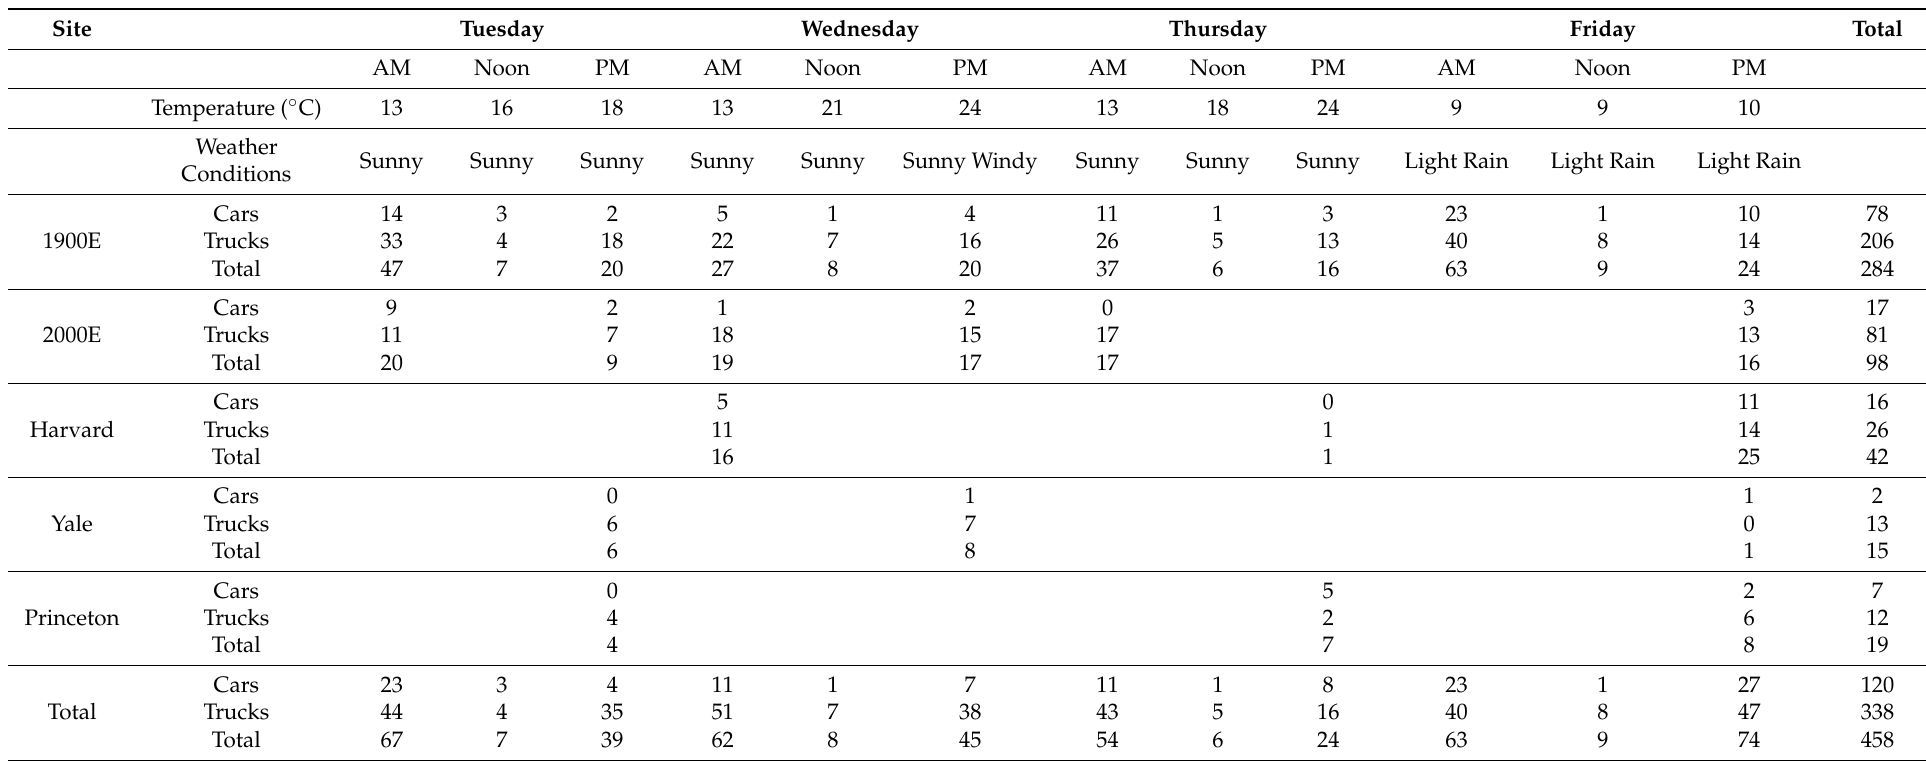
Table 3. Total vehicle counts during the pre-intervention week: 17–20 September